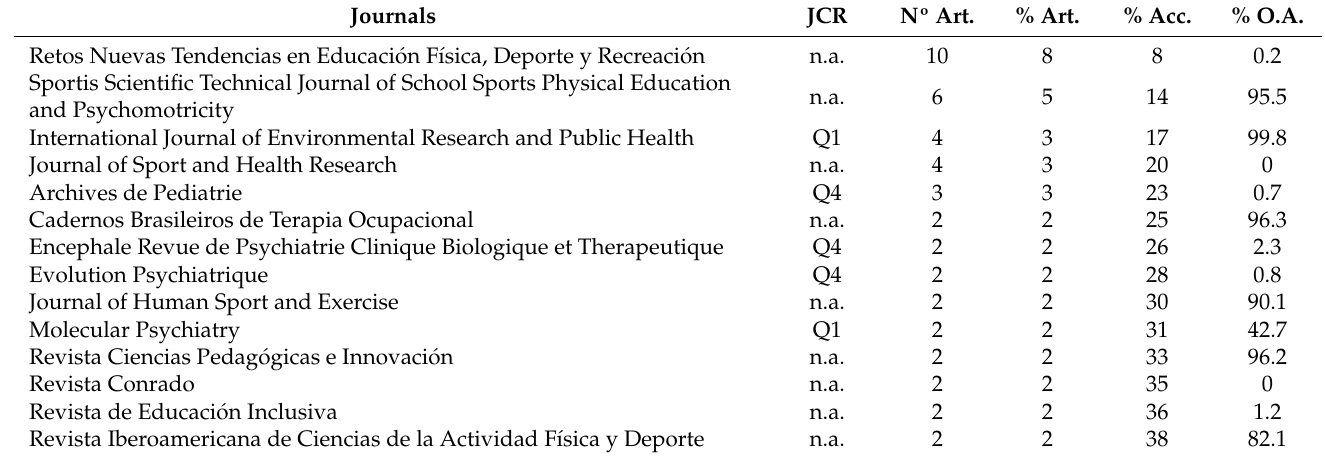
Table 2. Bradford’s journals core, according to the number of articles in psychomotricity. Journals JCR Nº Art. % Art. % Acc.